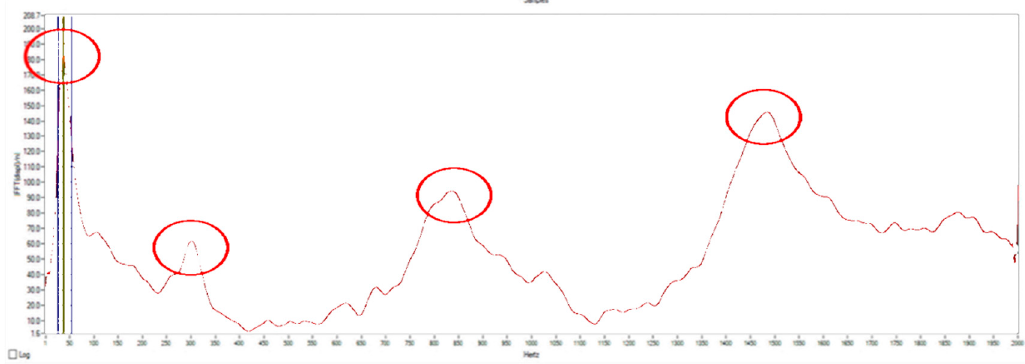
Figure 3. Frequency response function of oscillating specimen: Identification of resonance peaks.